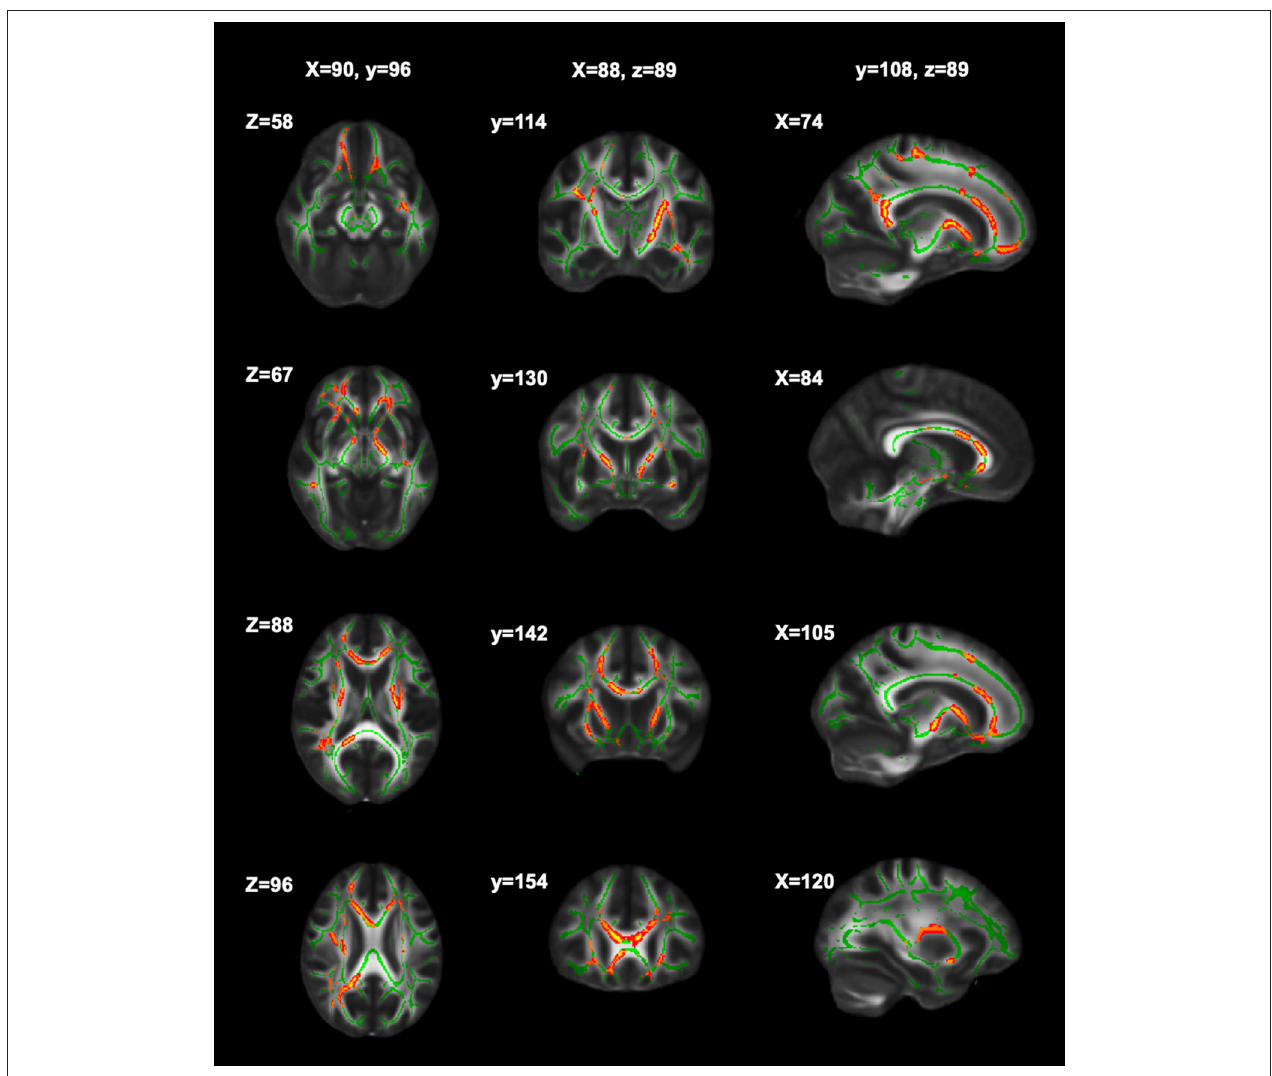
FIGURE 1 | Significant clusters of RK in relation to cognitive fatigue rate. Significant clusters (red) showing where RK is positively related to cognitive fatigue rate (i.e., as RK increases, cognitive fatigue rate